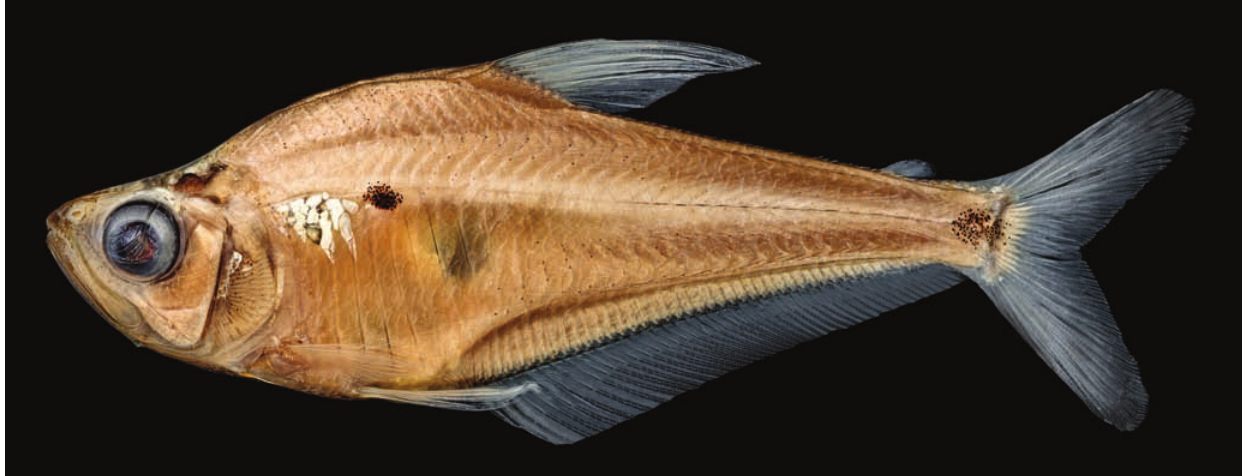
Fig. 13. Charax hemigrammus , MZUSP 62079, female, 40.5 mm SL, Brazil, Amazonas, Tapera, rio Negro.